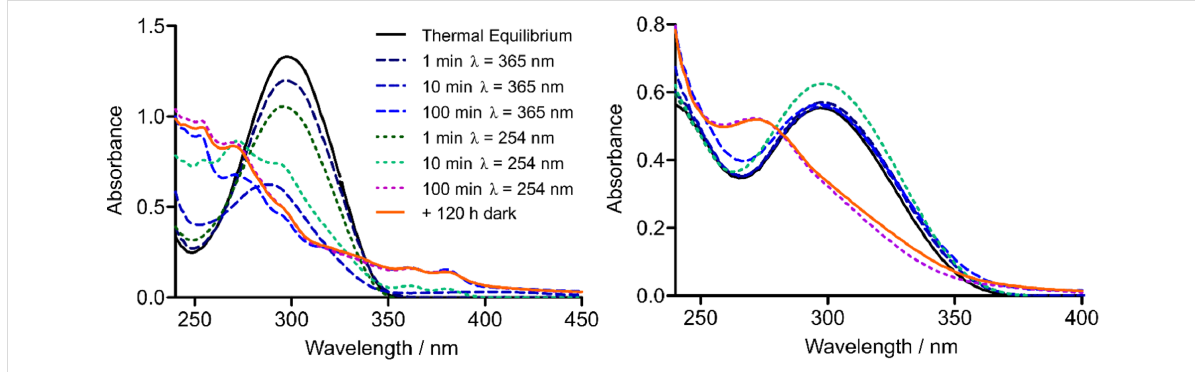
Figure 2: (Left) UV–vis spectrum of 2b 50 µM in 5% DMSO (v/v) in assay buffer after varying durations of irradiation with 254 nm and 365 nm, re- spectively. (Right) UV–vis spectrum of 2f 50 µM in 5% DMSO (v/v) in assay buffer after varying durations of UV radiation.